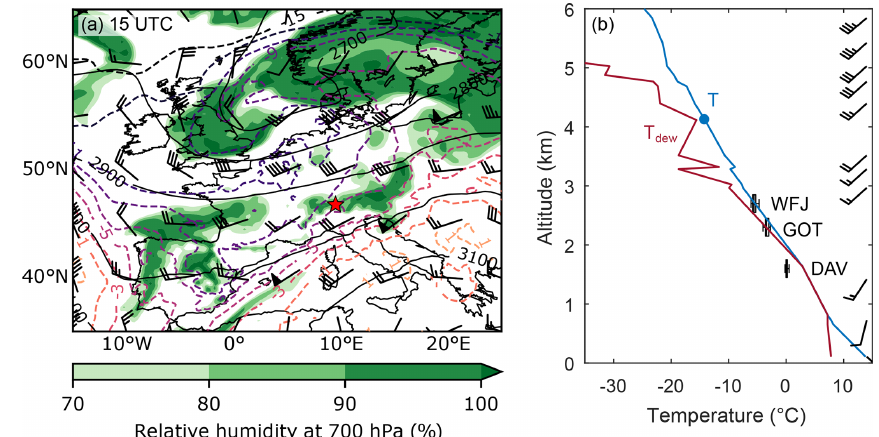
Figure 2. Overview of the synoptic weather situation on 7 March 2019 showing a map of ERA5 reanalysis data at 700hPa height with a horizontal resolution of 0.25 ◦ (a) and the temperature profile of a radiosonde ascent (b) . The reanalysis shows the relative humidity in percent (colored area), the temperature in degrees Celsius (dashed lines), the geopotential height in meters (black lines), and the wind speed and direction in knots (wind barbs) at the 700hPa pressure level at 15:00UTC (data obtained from the C3S Climate Data Store, dataset by Hersbach et al., 2018). The 700hPa pressure level was chosen as it represents the mean Alpine ridge height. The red star indicates the measurement location. The radiosonde was launched from Milan (12:00UTC; source: UQAM-Montreal Weather Centre) and shows the temperature (blue) and dew point temperature (red) profiles. The boxplots in (b) show the temperature measured at Davos (DAV; 1600m), Gotschnagrat (GOT; 2300m) and Weissfluhjoch (WFJ; 2700m) during the measurement period. The cloud top temperature ( − 14 ◦ C) and height (4000m; estimated from cloud radar observations averaged between 17:00 and 18:30UTC) are indicated by the blue dot. The wind barbs are shown on the right